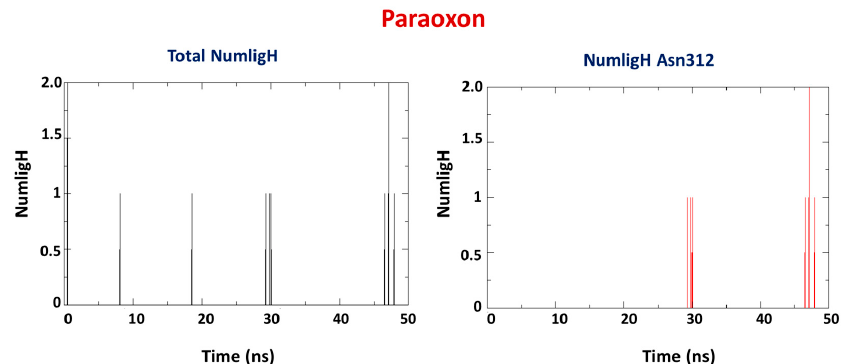
Figure 8. H-bond prevalence for the system PTE/PXN and PTE/NEMP.